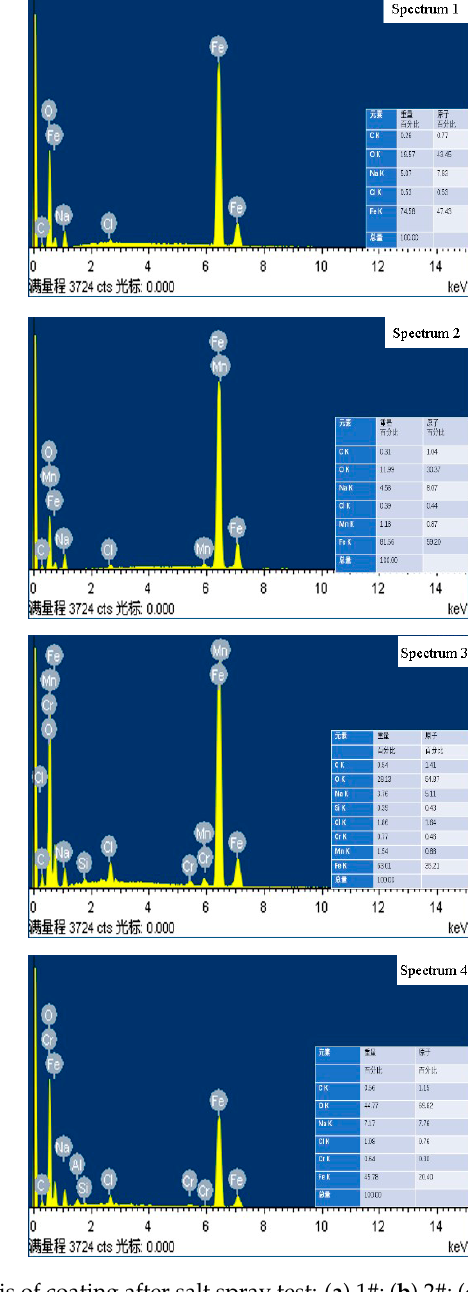
Figure 8. Surface morphology and energy spectrum analysis of coating after salt spray test: ( a ) 1#; ( b ) 2#; ( c ) 3#; ( d ) 4#. Table 5. Atomic percentage content measured by